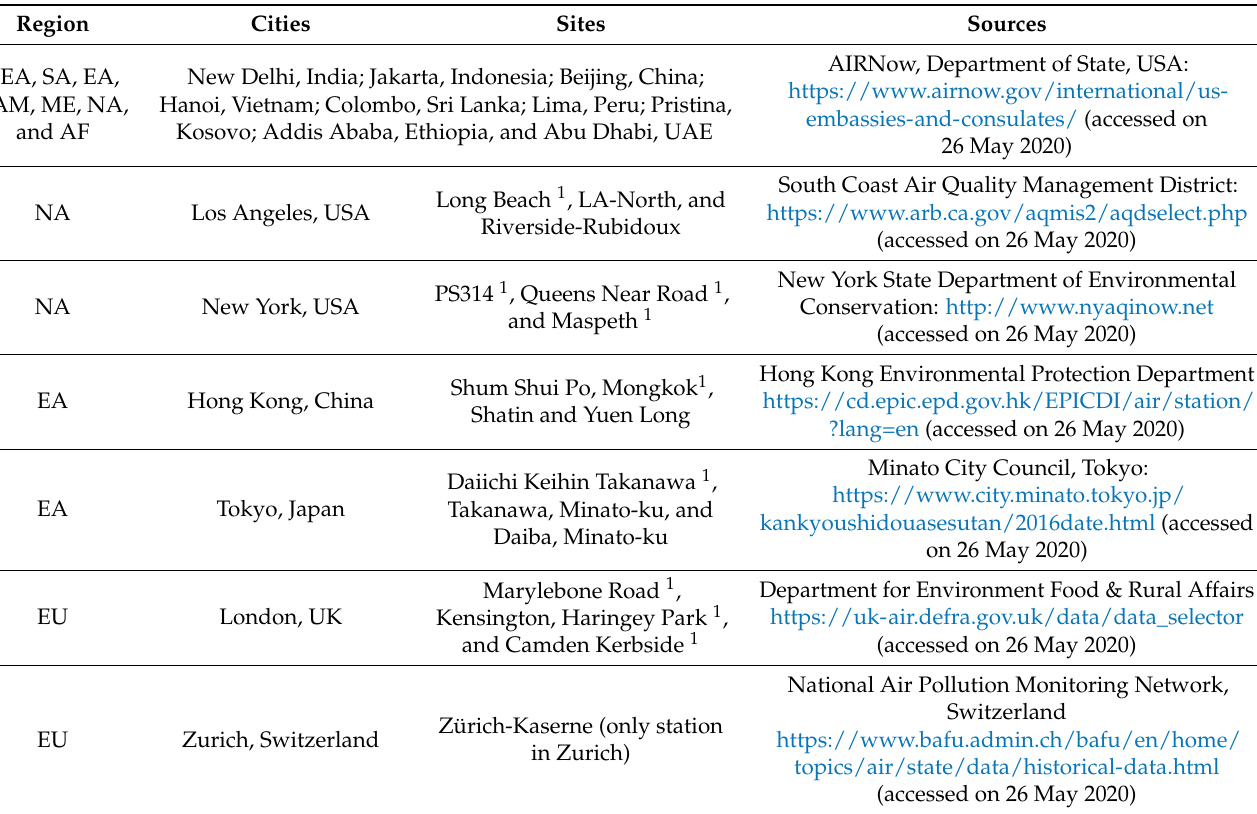
Table 1. Selected cities with their air quality